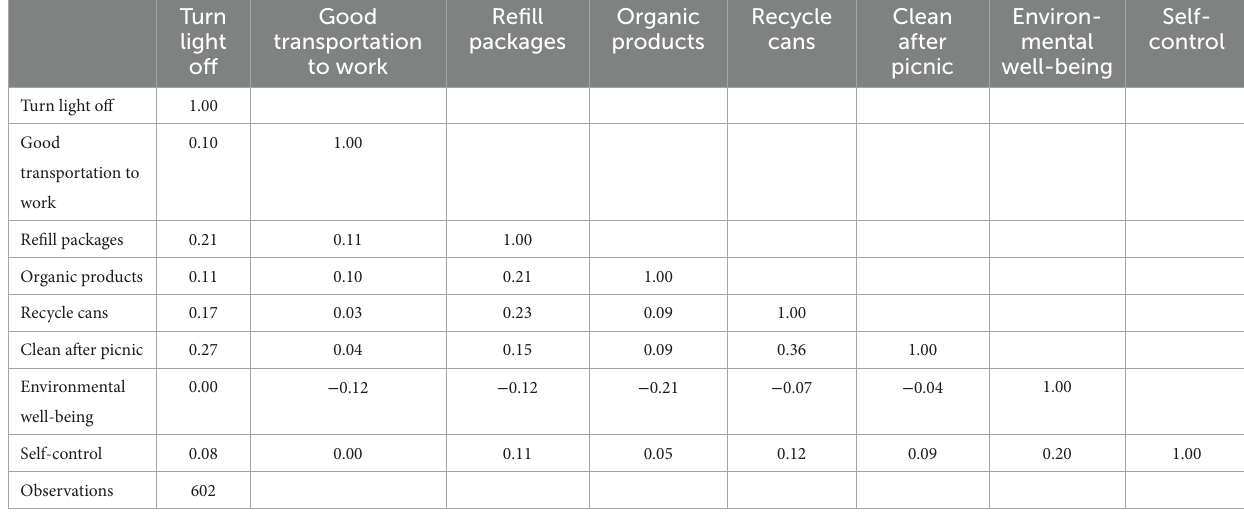
TABLE 3 Correlations between the dependent variables and